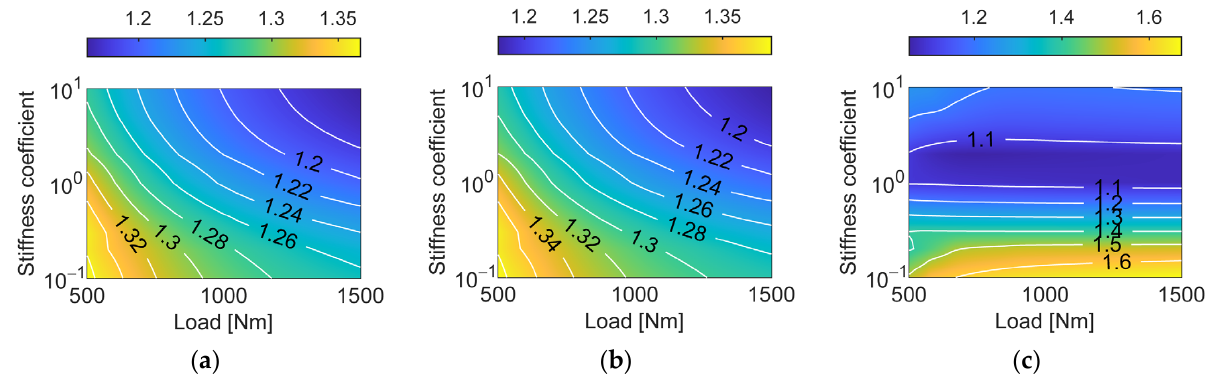
Figure 16. In fl uence of support sti ff ness of Idler 1 on load-sharing coe ffi cient: ( a ) Input Gear 1; ( b ) Input Gear 2; ( c ) idler gear.